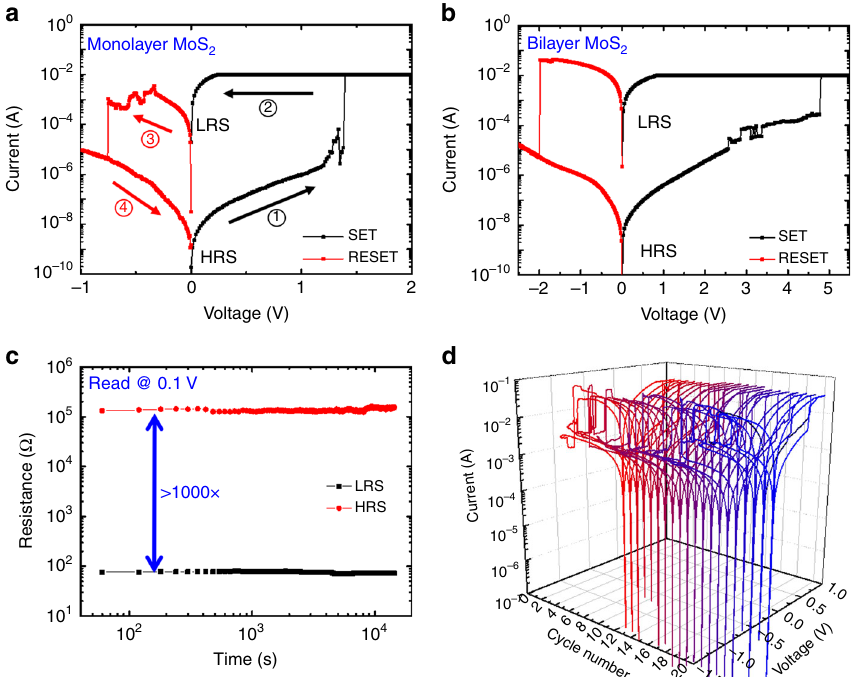
Fig. 2 DC switching characteristics of MoS 2 atomristors. a Representative I – V curve of the bipolar resistance switching effect in a monolayer MoS 2 RF switch with lateral area of 0.5 × 0.5 μ m 2 . Step 1: voltage increases from 0 V. At ~1.4 V, the current abruptly increases to compliance current, indicating a transition (SET) from a high-resistance state to a low-resistance state. Step 2: voltage decreases from 2 to 0 V. The device persists in the low-resistive state. Step 3: voltage decreases from 0 to − 1 V. At approximately − 0.7 V, the current abruptly decreases, indicating a transition (RESET) from LRS to HRS. Step 4: voltage returns back to 0 V. The device persists in HRS until the next cycle. b Representative I – V curve of the bipolar resistance switching effect in a bilayer MoS 2 RF switch with lateral area of 0.5 × 0.5 μ m 2 showing similar switching pro fi le. c The retention measurement of a monolayer MoS 2 switch with lateral area of 0.5 × 1 μ m 2 at room temperature revealing stable operation. The HRS and LRS resistance are determined by measuring the current at a small bias of 0.1 V. d Typical DC cycling of monolayer MoS 2 non-volatile resistance